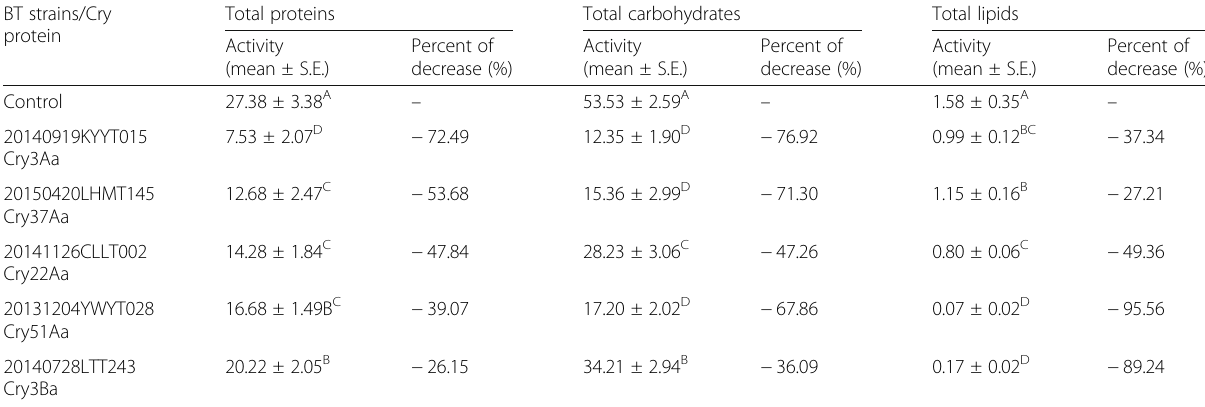
Table 5 Energy reserves of treated third instar larvae of Tribolium castaneum at LC30 of Bt strains/Cry protein after 5 days of continuous exposure to the insecticide BT strains/Cry protein